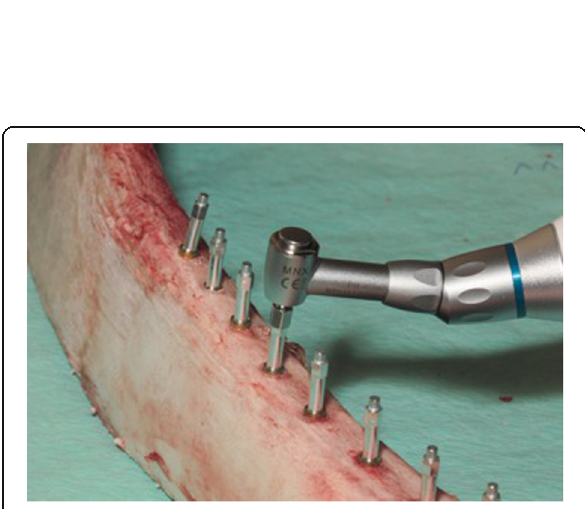
Fig. 2 Smartpeg on implants. Mechanical insertion of smartpegs into implants in control group with a defined insertion torque of 5 Ncm using an electronical Meg Torq device (Megagen Implants UK, Luton Bedfordshire,